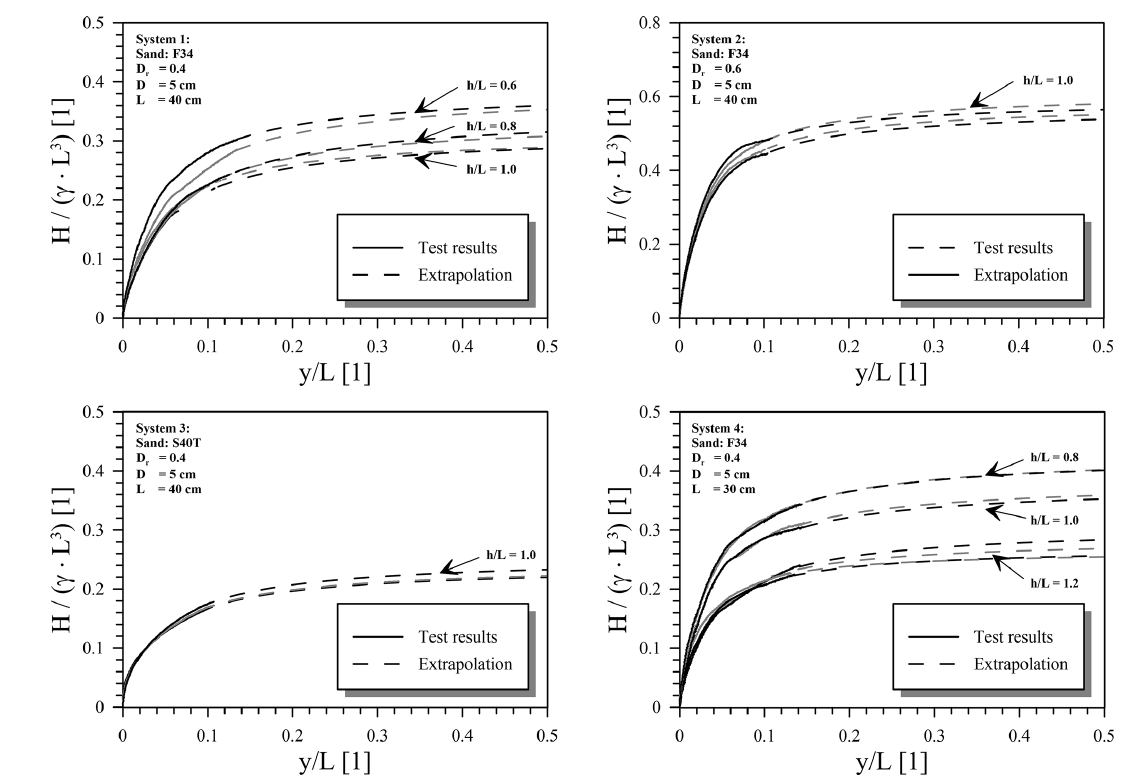
Figure 5. Load-displacement curves from monotonic lateral load tests and extrapolations according to Manoliu et al.